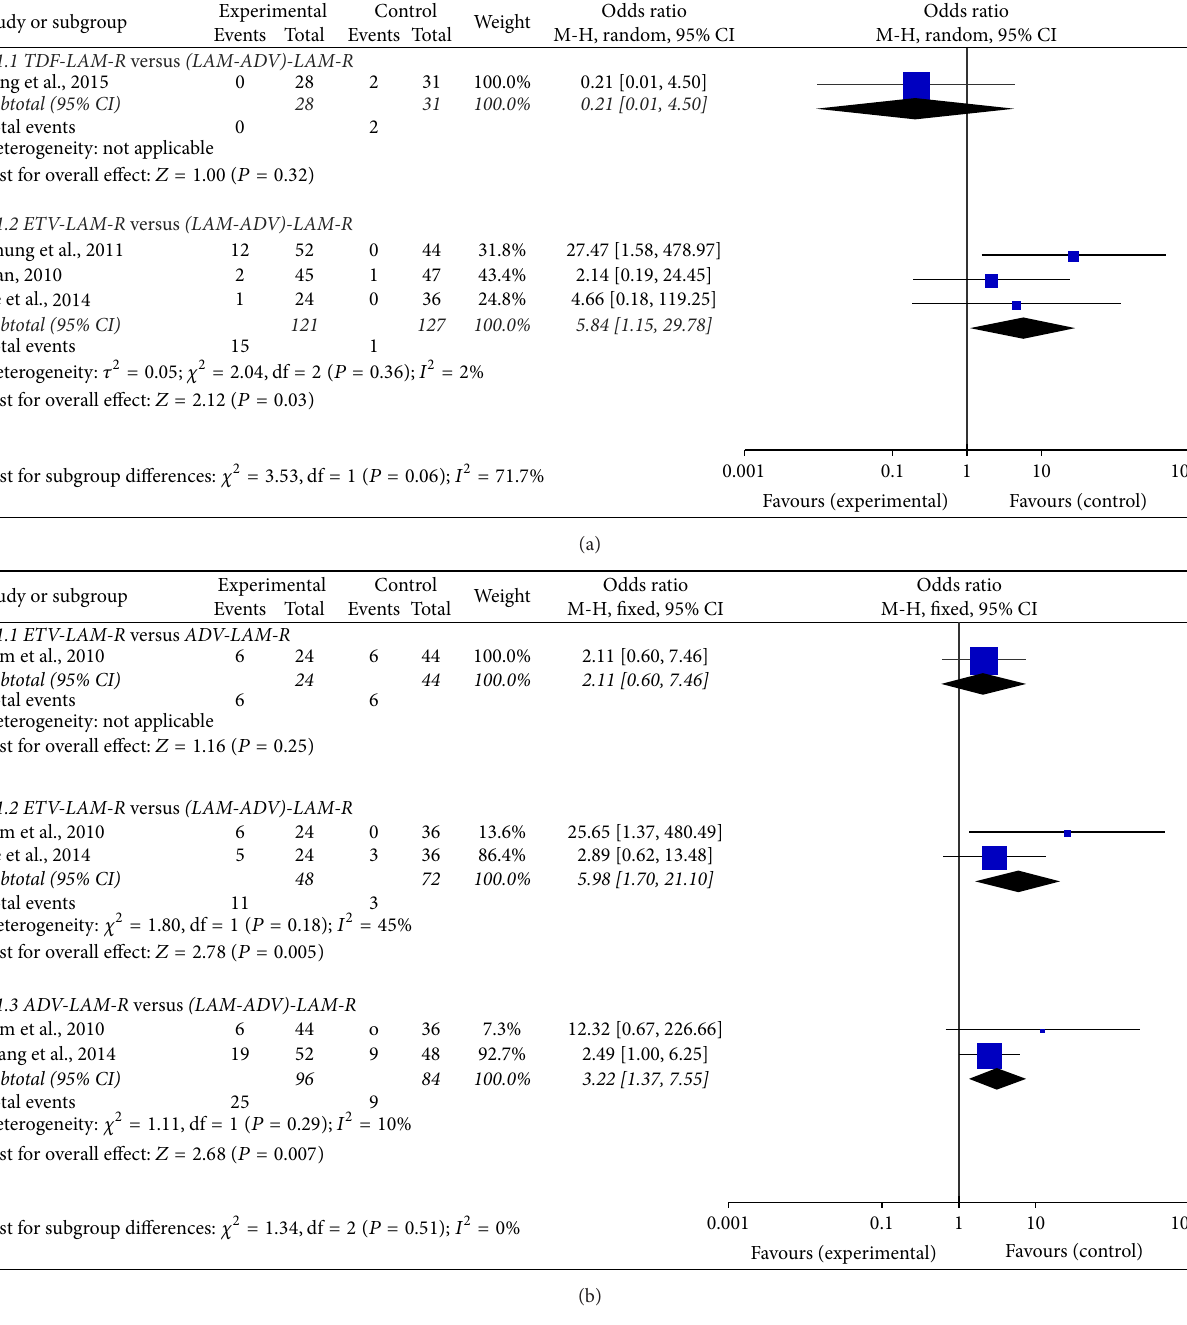
ALT normalization and HBeAg loss are usually associated with improved clinical outcomes. In this study, among TDF, ETV, LAM/ADV, and ADV, the results of direct and indirect meta-analysis revealed that no drug was clearly superior to others in the rates of ALT normalization and HBeAg loss compared with each other after 48 weeks of therapy. However, on comparative effectiveness network meta-analysis, TDF, ADV, and LAM/ADV had the highest probability of being